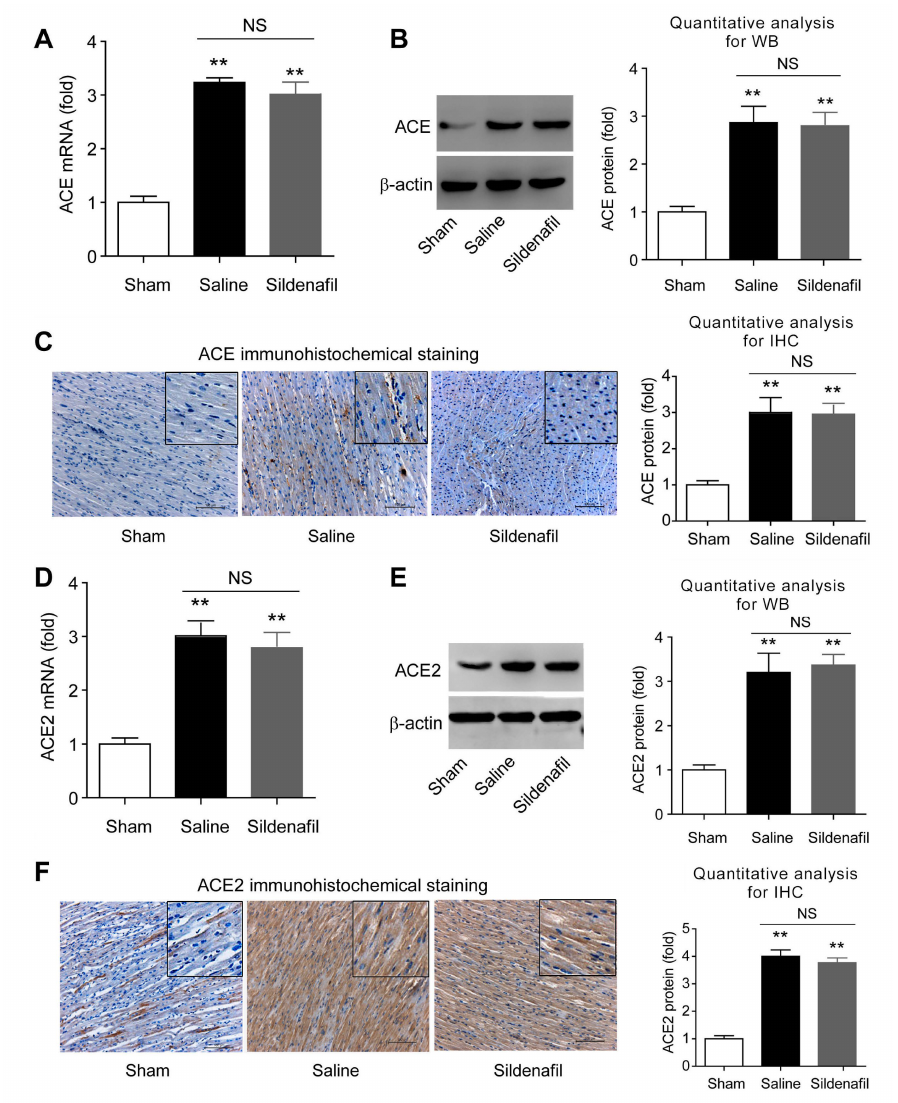
Figure 6. Tissue mRNA and protein levels of ACE and ACE2 in myocardial tissue after post-resuscitation in a porcine myocardial I/R injury model. Effects of sildenafil on ACE expression were assayed by qRT-PCR ( A ), Western blotting ( B ), and immunohistochemistry ( C ), and compared to the sham and saline-treated groups. ** p < 0.01 vs . Sham; NS, no significance. n = 6–10 per group. Effects of sildenafil on ACE2 expression were measured by qRT-PCR ( D ), Western blotting ( E ), and Immunohistochemistry ( F ), and compared to the sham and saline-treated groups. ** p < 0.01 vs . Sham; NS, no significance. n = 6–10 per group. Scale bar in C , F : 100 µ m.